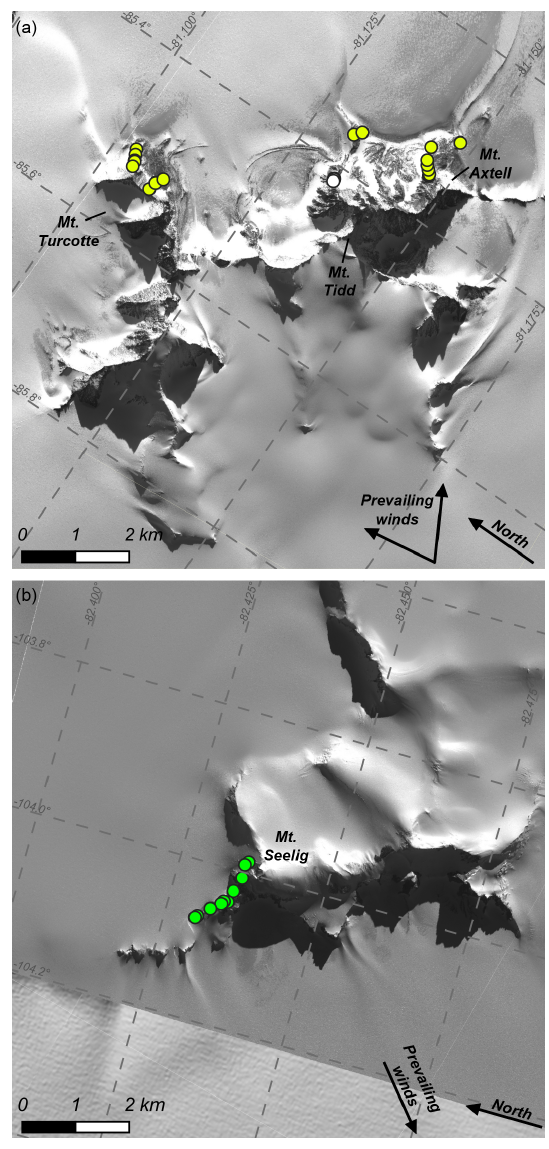
Figure 2. WorldView satellite imagery (copyright 2012 Digital- Globe, Inc.) of the Pirrit Hills (a) and Mt. Seelig in the Whitmore Mountains (b) . Circles show the locations of samples discussed in the text, and their colors correspond to the circles in Fig. 3. Wind direction arrows are based on the orientation of snow tails visible in the satellite imagery. The range of wind directions shown in panel (a) reflects the fact that the wind orientation varies with location around the mountains. The wind direction is relatively constant in panel (b) and so a single vector is